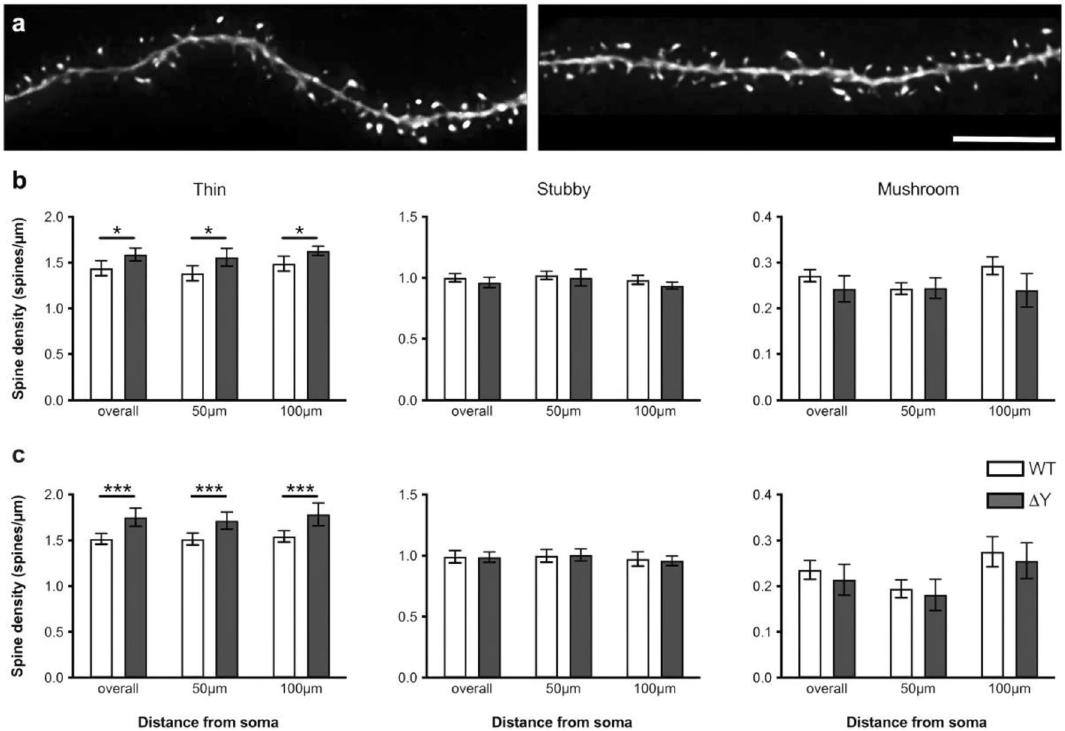
Figure 3. ΔY mutation in MHC-I increases the density of thin spines ( a ) Representative confocal images of apical dendritic segments of CA1 pyramidal neurons from WT (left) and ΔY mice (right). Scale bar = 5 μm. There was a significant increase in the density of ( b ) apical and ( c ) basal thin spines in ΔY compared to WT mice. There was no change in the density of stubby and mushroom spines. Note the different scales on the Y-axis for each spine type. * P < 0.05, *** P < 0.001. Data represent means ±